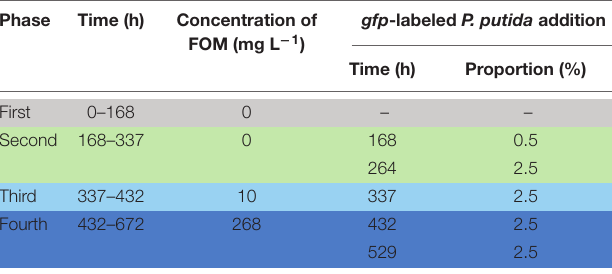
TABLE 1 | Continuous cultivation: times of augmentation of gfp -labeled P. putida KT2440 (in % proportions to the WWC) and of fosfomycin (FOM, mg L − 1 ).